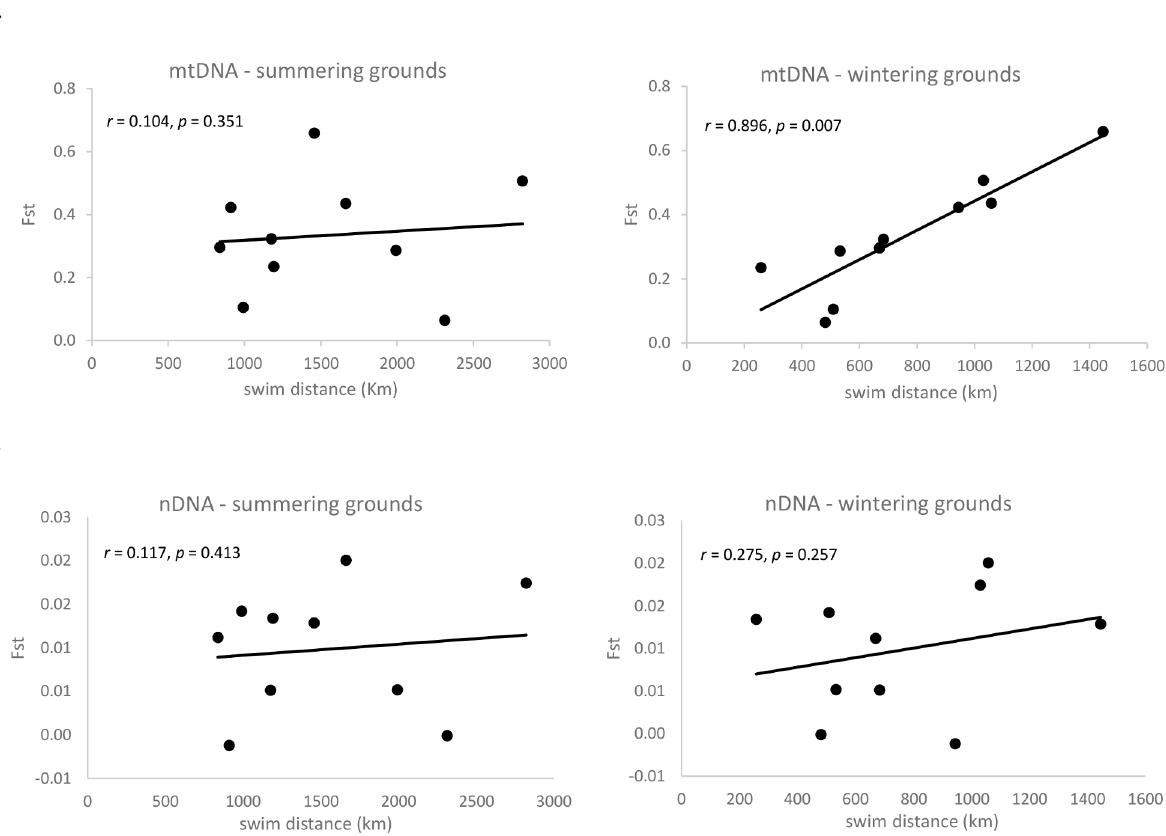
Fig 4. Mantel tests of the correlation between genetic differentiation ( F st ) and geographic distance among summering and wintering grounds of beluga whales in the Bering, Chukchi and Beaufort Seas, for both (A) mitochondrial DNA and (B) microsatellite markers.Test p values are based on 10,000 permutations of the distance